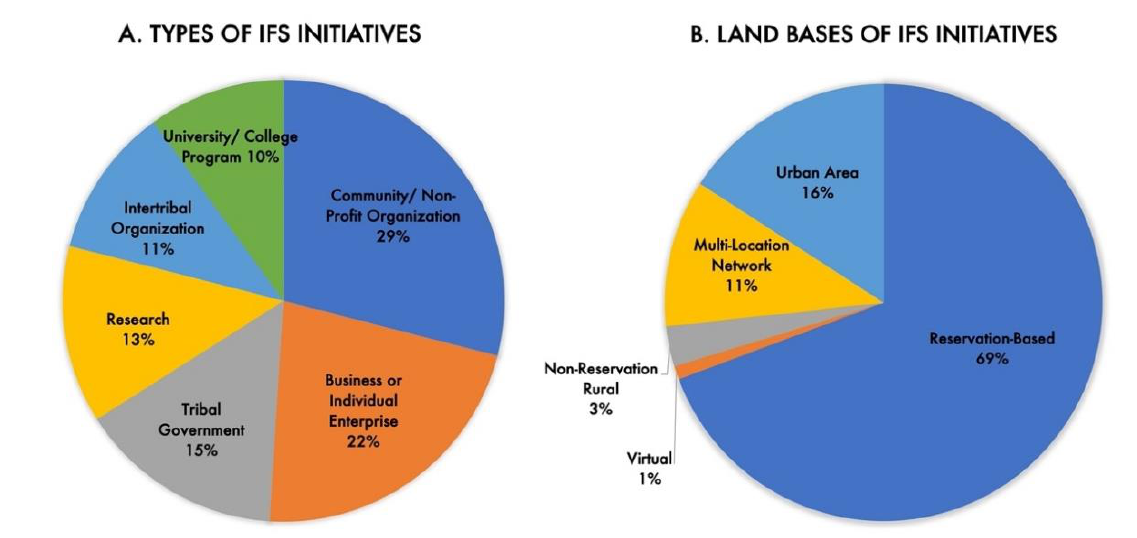
Figure 1. Western U.S. Indigenous Food Sovereignty Initiatives Categorized by Type and Land